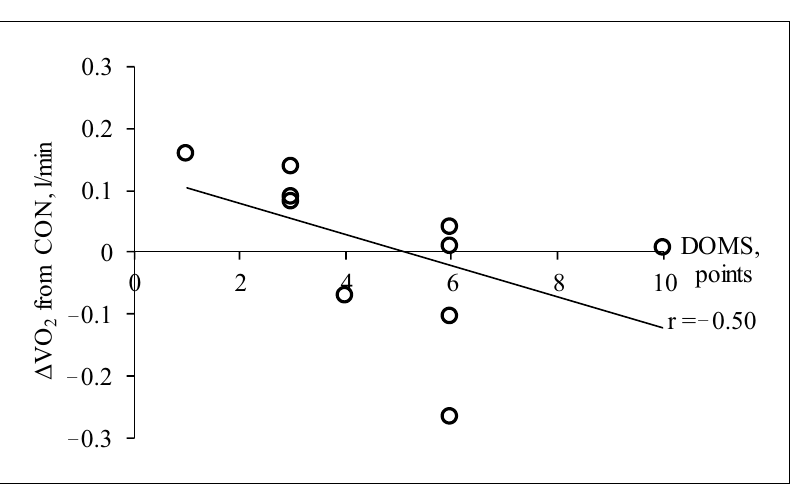
Figure 4. The correlation between changes (from control moderate cycling conditions (CON)) on oxygen uptake